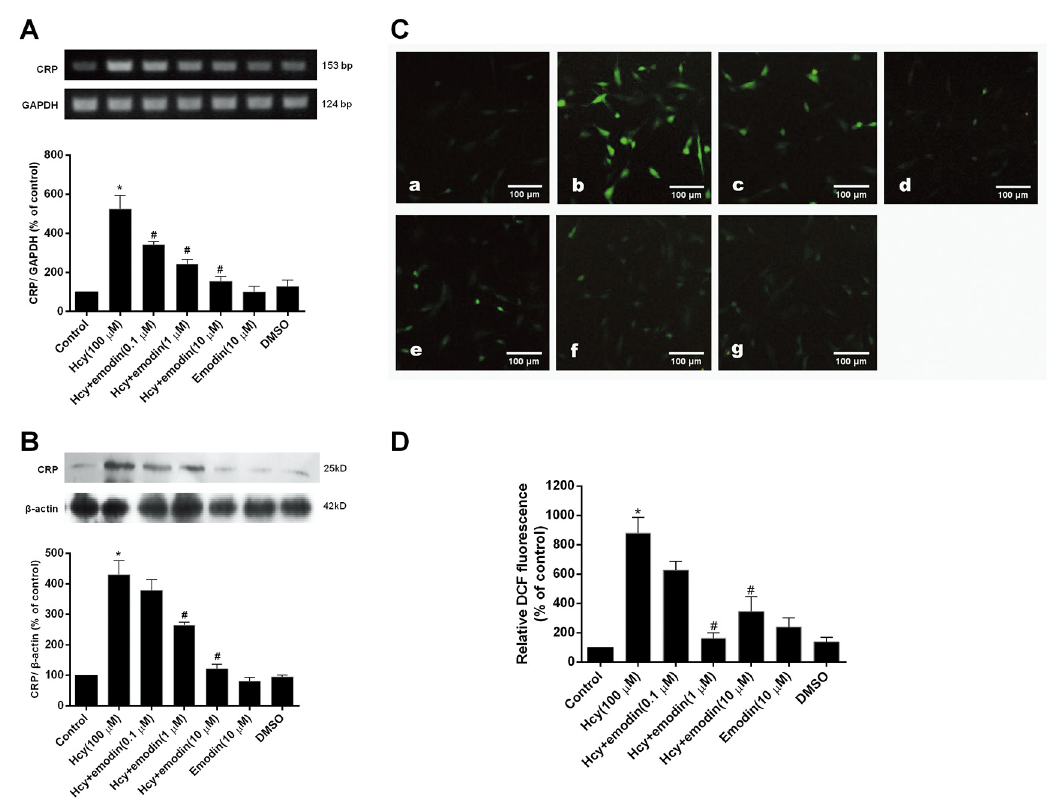
Fig 2. Effects of emodin on Hcy-stimulated CRP expression and ROS generation in VSMCs. The cells were preincubated with the different concentrations of emodin for 24 h before stimulation with 100 μ M homocysteine (Hcy) for 12 h. mRNA (A) and protein (B) expression of CRP was identified by RT-PCR and Western blot, respectively. In another experiment, the cells were incubated with the different concentrations of emodin for 24 h and then, exposed to 100 μ M Hcy for 40 min after preloaded with H 2 DCF-DA (10 μ M) for 30 min. The fluorescent intensity was measured by a fluorescence microscope. (C) Representative fluorescence images: (a) control, (b) Hcy alone, (c) Hcy + 0.1 μ M emodin, (d) Hcy + 1 μ M emodin, (e) Hcy + 10 μ M emodin, (f) 10 μ M emodin, (g) 0.1% DMSO. (D) Relative fluorescence intensity quantified from the fluorescence images. Emodin alone was used as drug control and DMSO (0.1%) was used as solvent control. Results from three independent experiments were expressed as means ± S.E.M. * P < 0.05 vs . control, # P < 0.05 vs . Hcy alone.